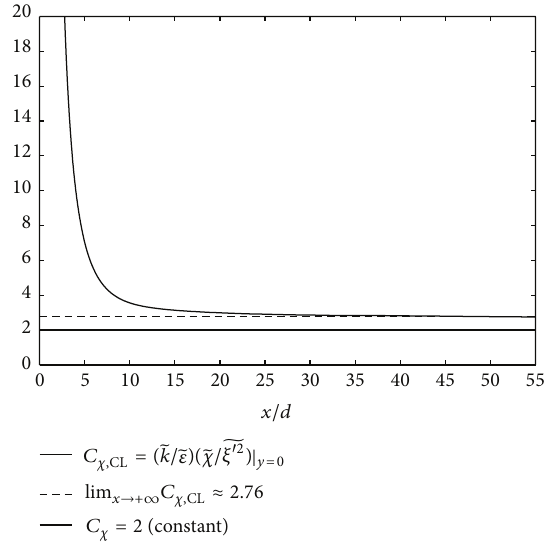
Figure 3: Evolution of the time scale ratio along the centreline.